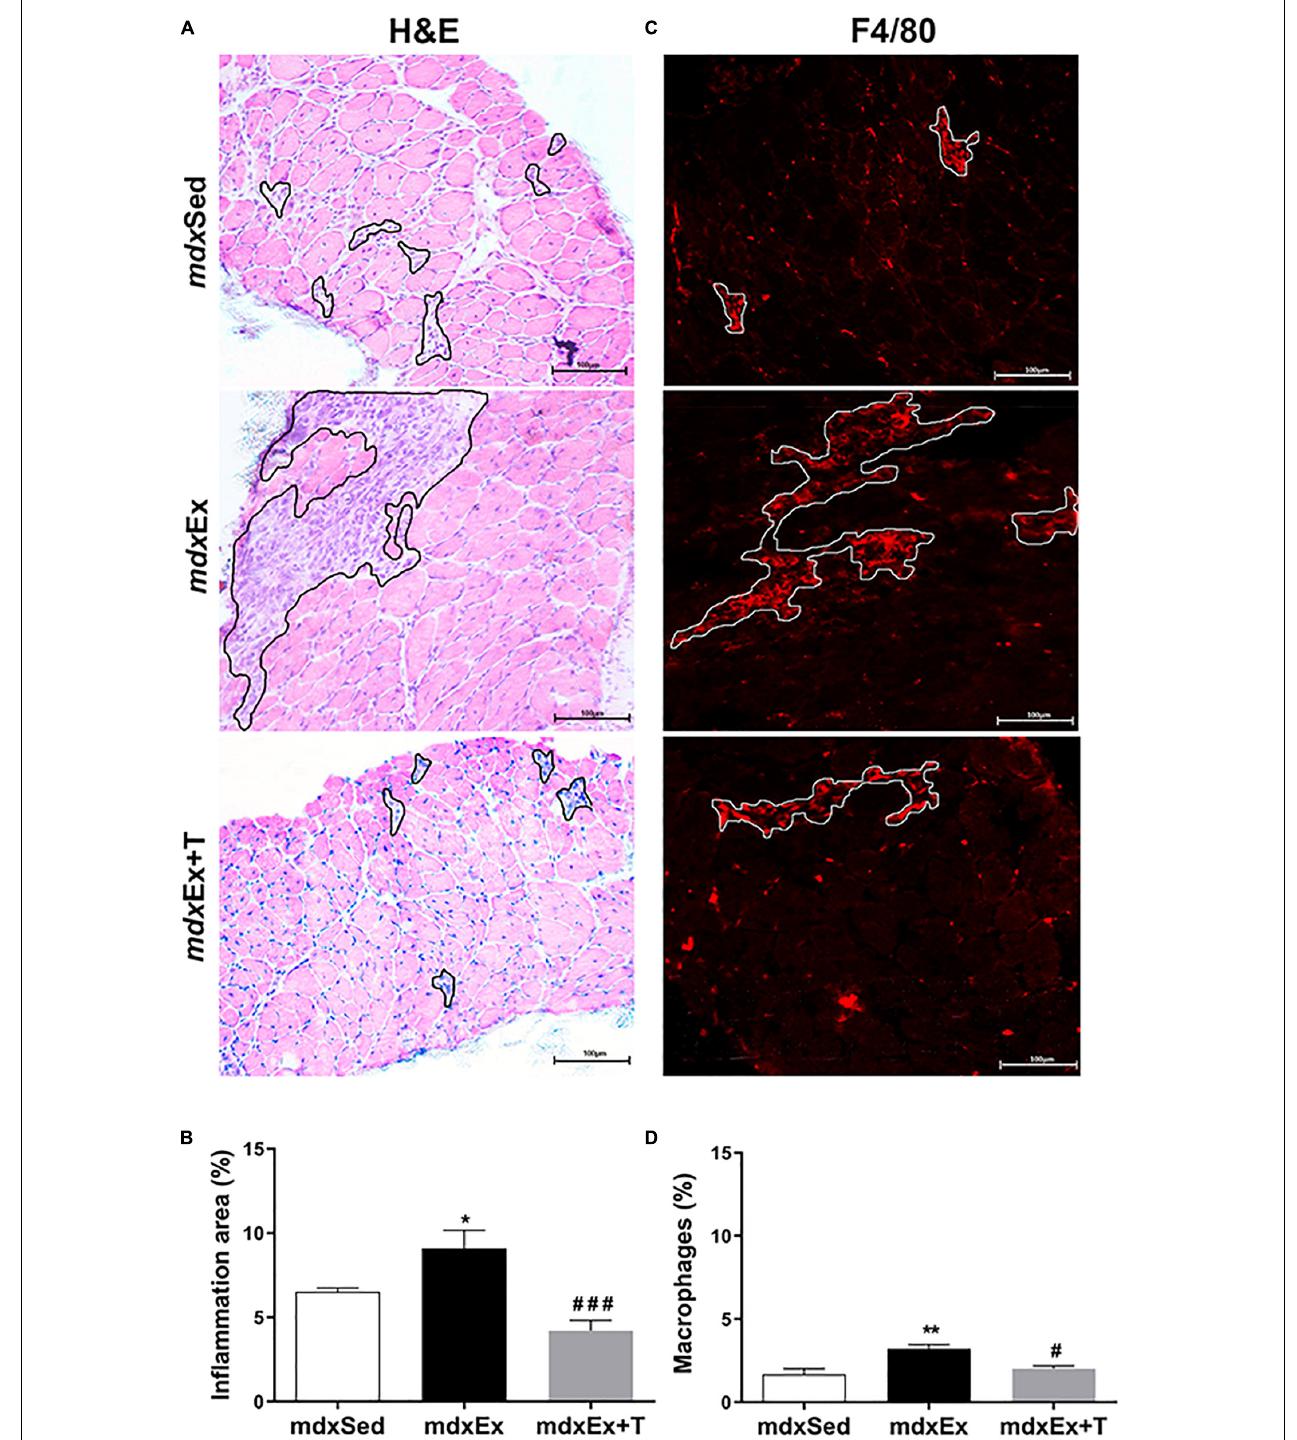
FIGURE 3 | Tempol effects on the inflammatory response morphology. (A) The outline indicates the representative area of inflammation in the diaphragm (DIA) of the sedentary mdx mice (mdx Sed), exercise trained mdx mice ( mdx Ex), and exercise trained mdx mice treated with Tempol ( mdx Ex+T). (B) Graphs show the inflammatory area (%) in the DIA muscles of the mdx Sed, mdx Ex, and mdx Ex+T groups. (C) The outline indicates the representative area of macrophage infiltration determined by F4/80 immunohistochemistry. (D) Graphs show the macrophage infiltration area (%) in the DIA muscles of the mdx Sed, mdx Ex, and mdx Ex+T groups. All values expressed as mean ± standard deviation (SD). * P ≤ 0.05 compared with the mdx Sed group, ** P ≤ 0.001 compared with the mdx Sed group, # P ≤ 0.05 compared with the mdx Ex group, ### P ≤ 0.0001 compared with the mdx Ex group (one-way ANOVA with Tukey’s post hoc test).